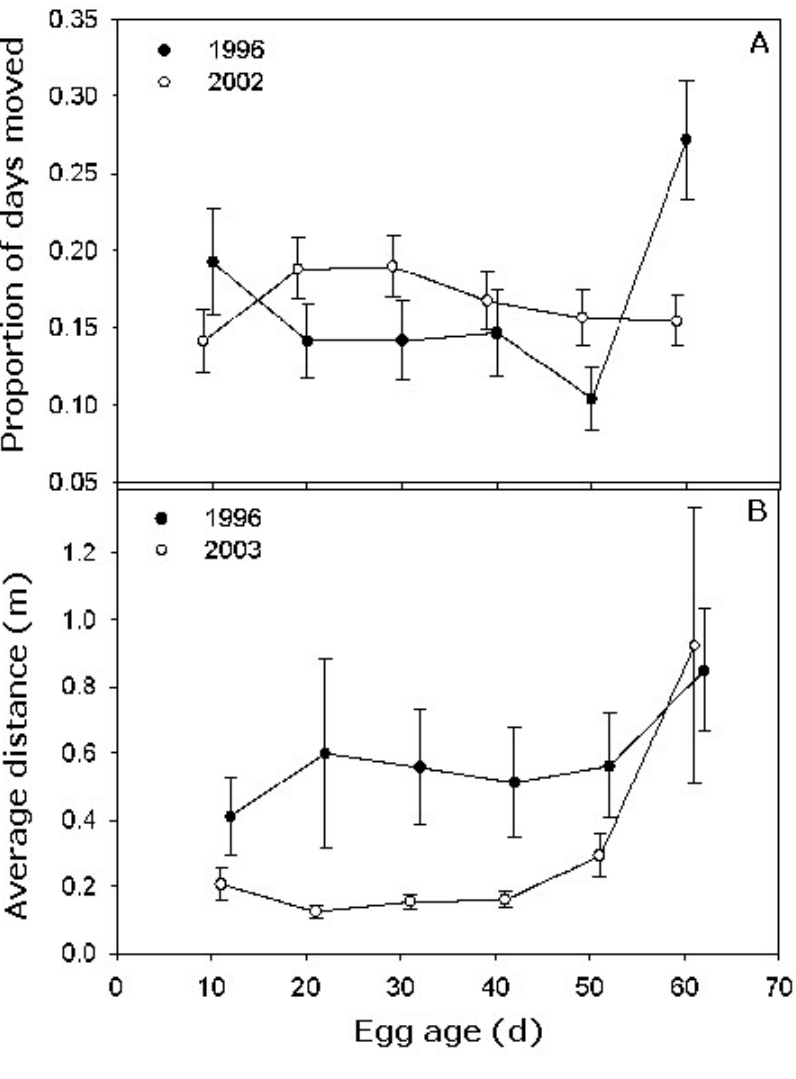
Fig. 2 . (A) Proportion of movement per 10 d intervals for eggs that were moved and incubated at least 60 d in 1996 ( n = 49) and 2002 ( n = 116). (B) Average distance eggs were moved per 10 d interval 1996 ( n = 56) and 2003 ( n = 153) for eggs that were incubated for at least 60 d in 1996 ( n = 56) and throughout the 30 d monitoring period in 2003 ( n =